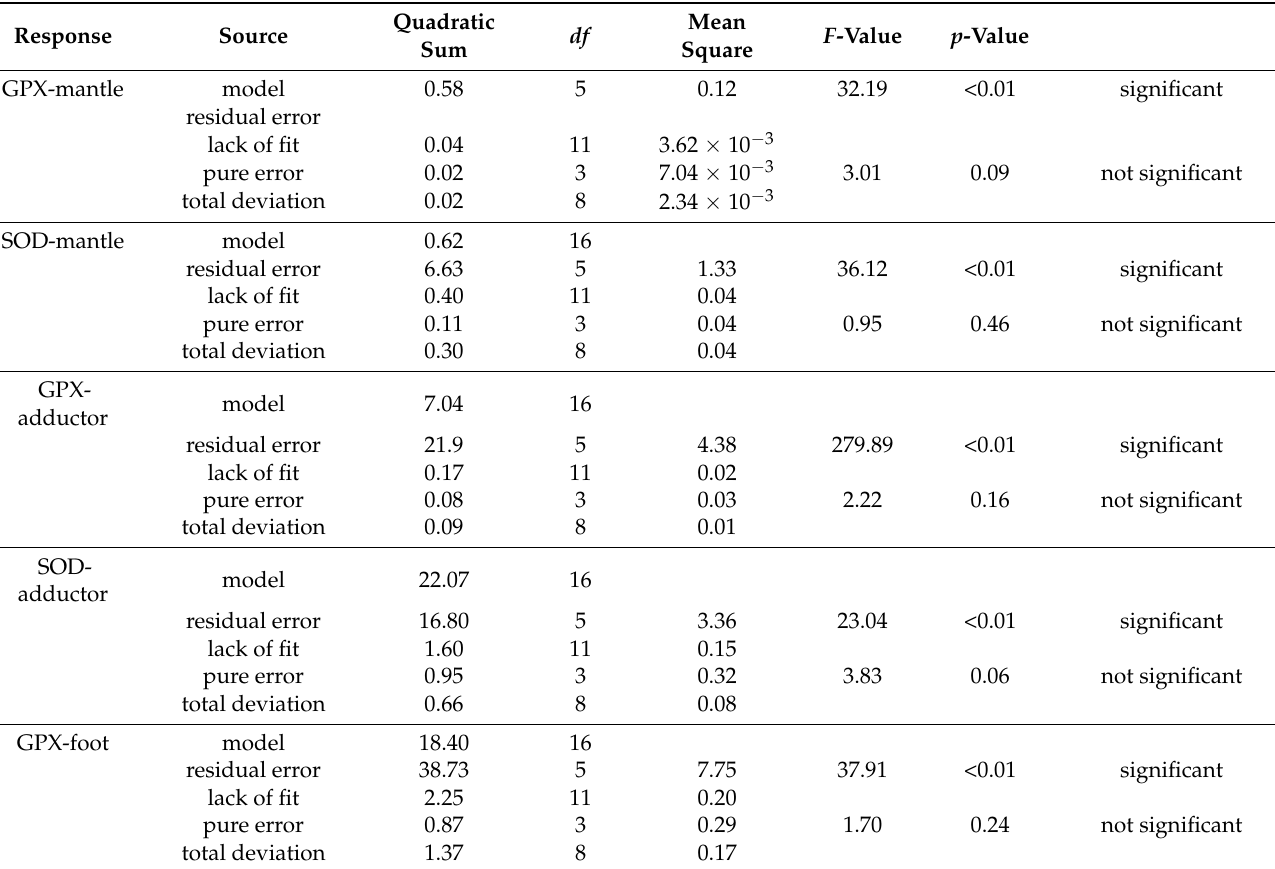
Table 6. Model variance analysis of relative expression indexes of antioxidant